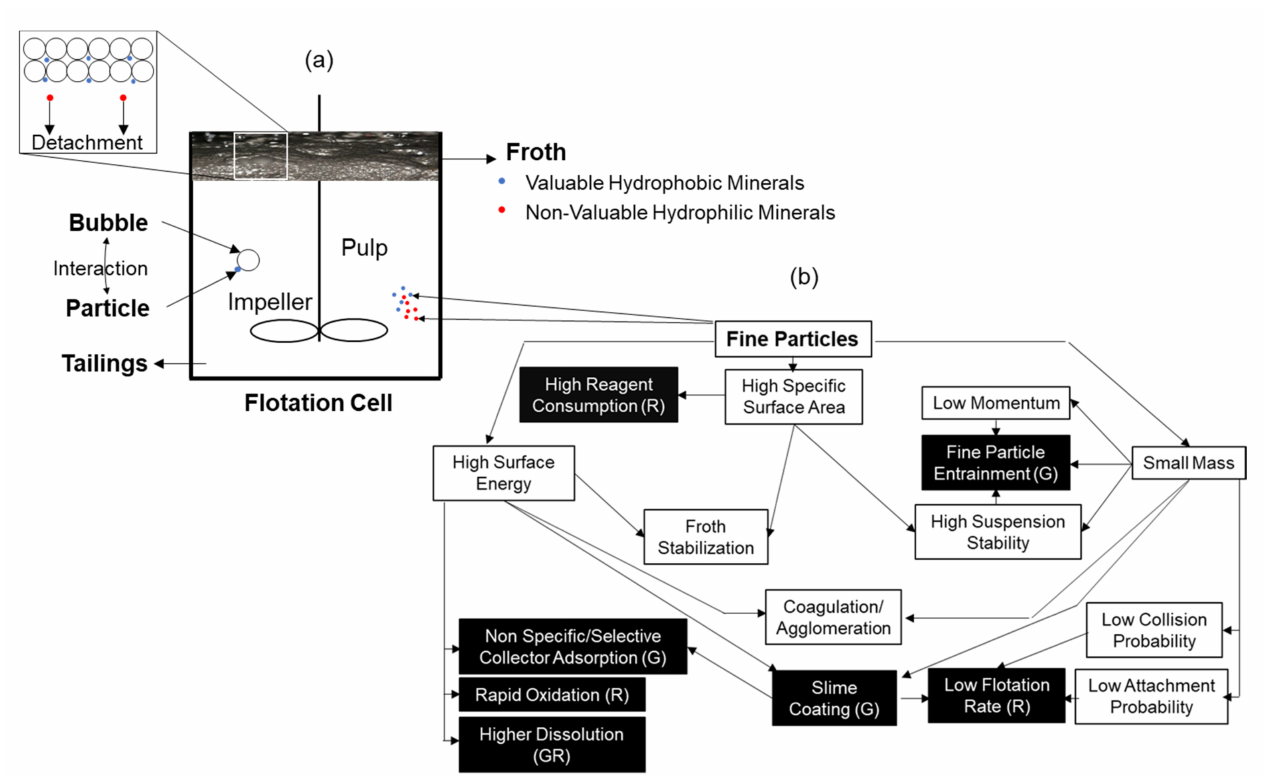
Figure 3. ( a ) Schematic explaining the principle of a mechanical froth flotation process. ( b ) Schematic diagram showing the relationship between physical and chemical properties of fine particles and their behaviors in flotation; (G) and (R) refer to whether the phenomenon affects the grade or recovery, individually or both together. The highlighted (black) cells indicate the possible drawbacks of the presence of fine particles on flotation performance. Redrawn and adapted from [83]. Used with permission of The Minerals, Metals & Materials